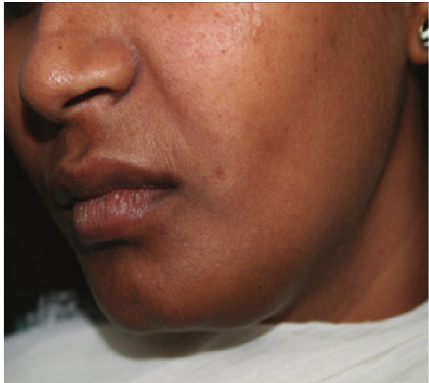
Figure 2: Photomicrograph showing diffuse swelling on lower left side of face.